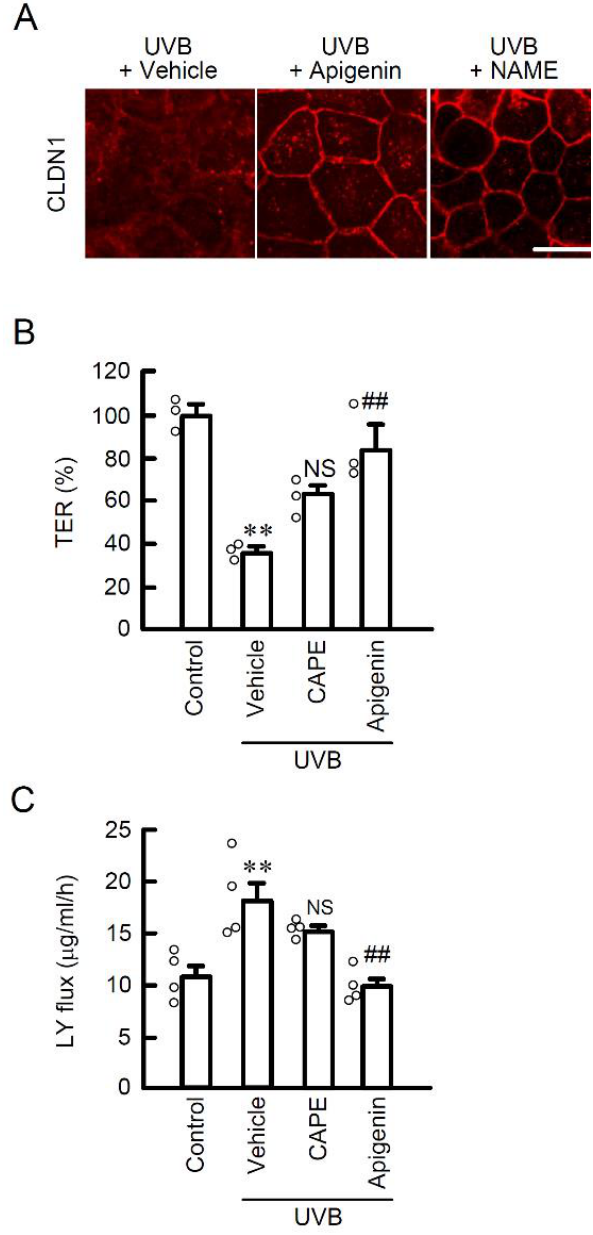
Figure 6. Effect of apigenin on TJ permeability and localization of CLDN1 in the weak UVB exposed cells. ( A ) Representative images of immunocytochemistry using anti-CLDN1 antibody. After expo- sure to weak UVB, the cells were cultured for 6 h in the absence (vehicle) and presence of 10 μM apigenin, or 100 μM L-NAME. Scale bar indicates 10 μm. ( B , C ) After exposure to weak UVB, the cell cultures on transwell plates were incubated for 6 h with 10 μM CAPE, or 10 μM apigenin. ( B ) TER was measured by volt-ohm meter. ( C ) Paracellular permeation of LY was detected using fluorescence spectrometry. n = 3–4. ** p < 0.01 vs. control. # p < 0.05, ## p < 0.01 and NS p > 0.05 vs. vehicle.